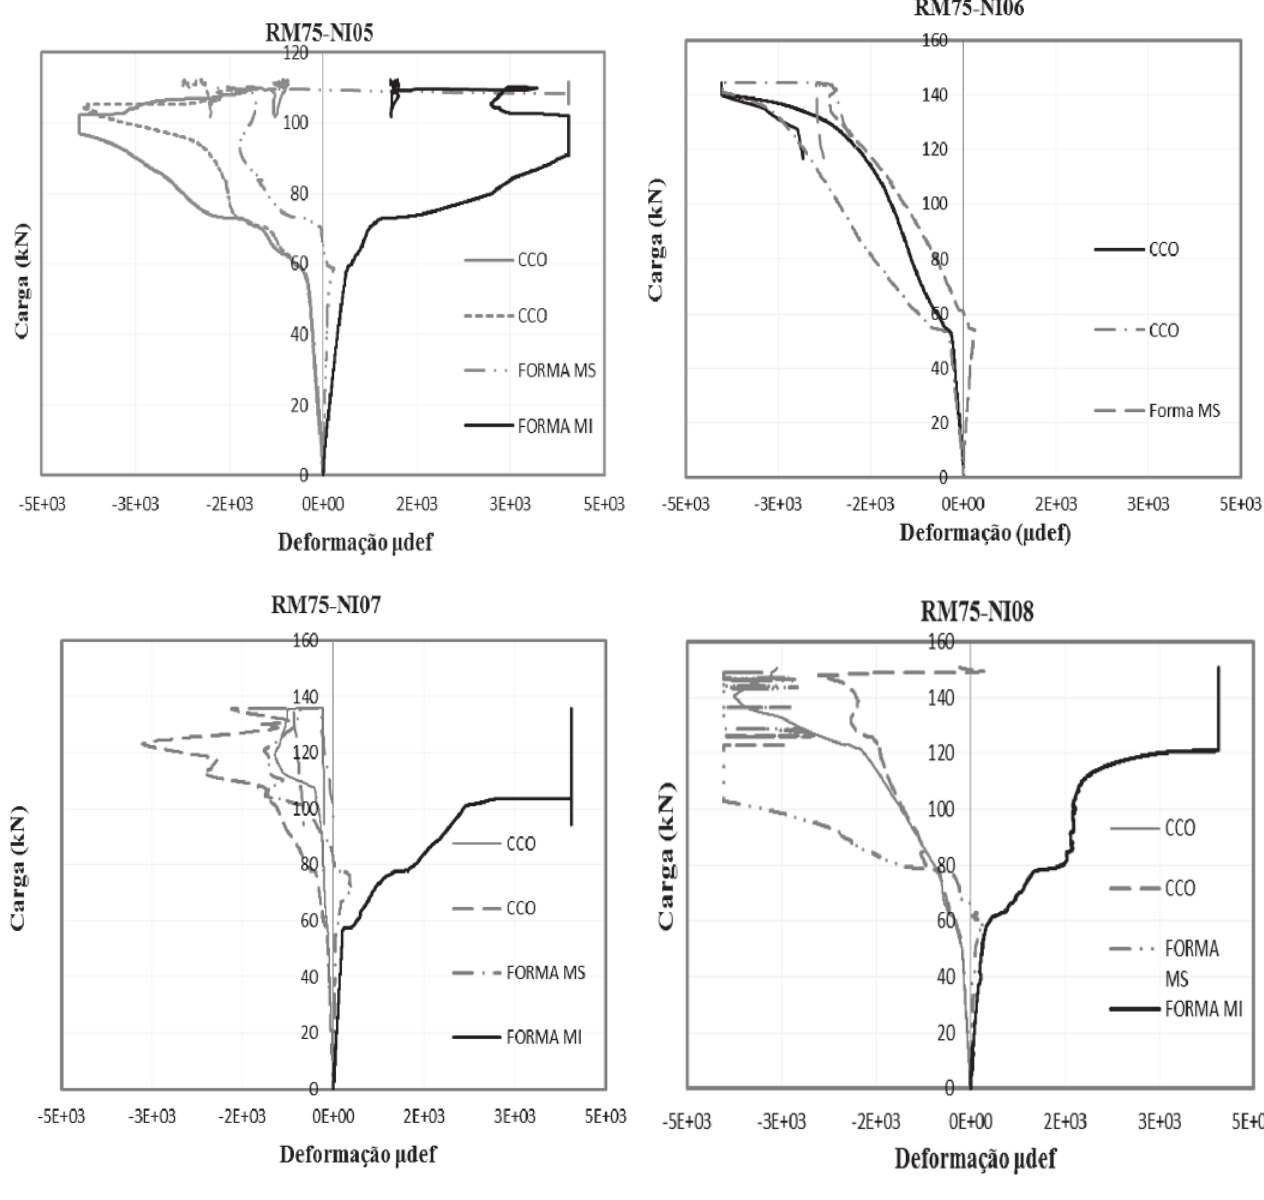
Carga x Deformação da amostra RM75-NI 05 a